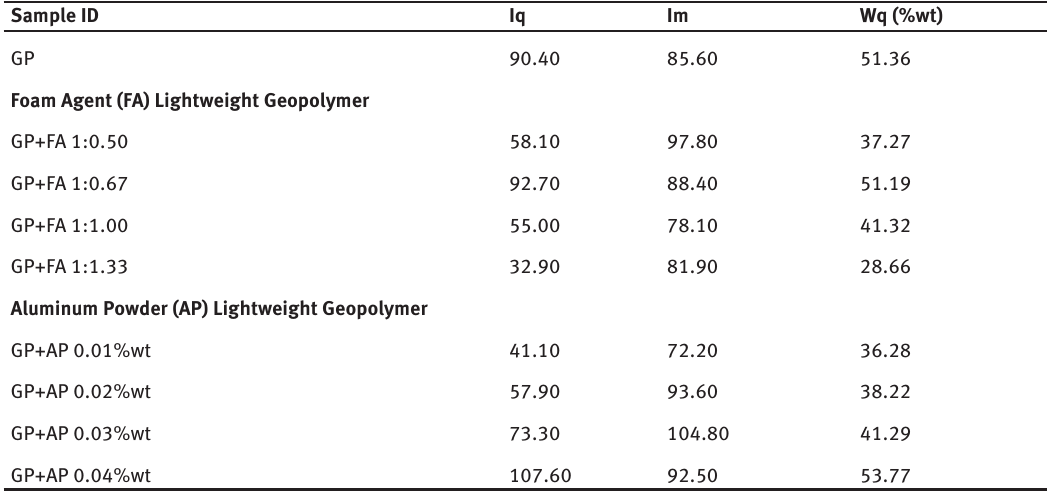
Table 2: Intensity comparison between quartz phase (Iq) and mullite phase in geopolymer and lightweight geopolymer matrix. Sample